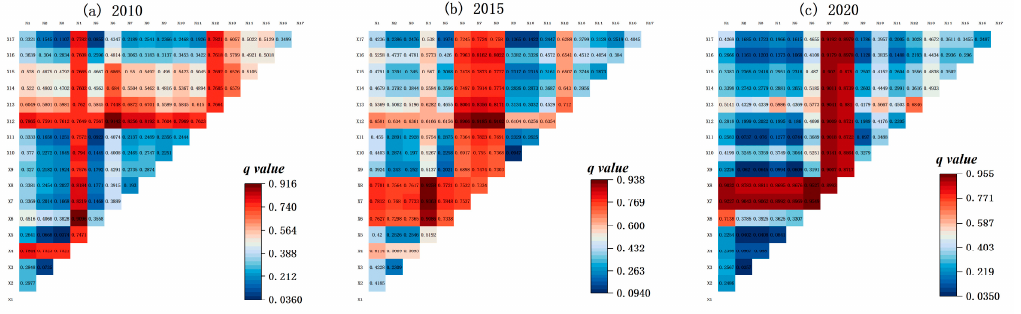
Figure 4. The results of interaction detection of ecological vulnerability in 2010 ( a ), 2015 ( b ) and 2020 ( c ).